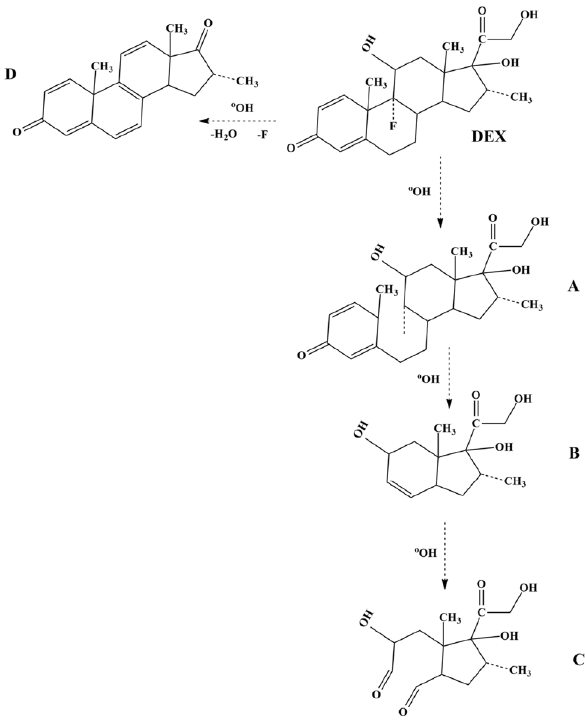
Figure 14. The degradation pathway of DEX under UV/H 2 O 2 /MgO